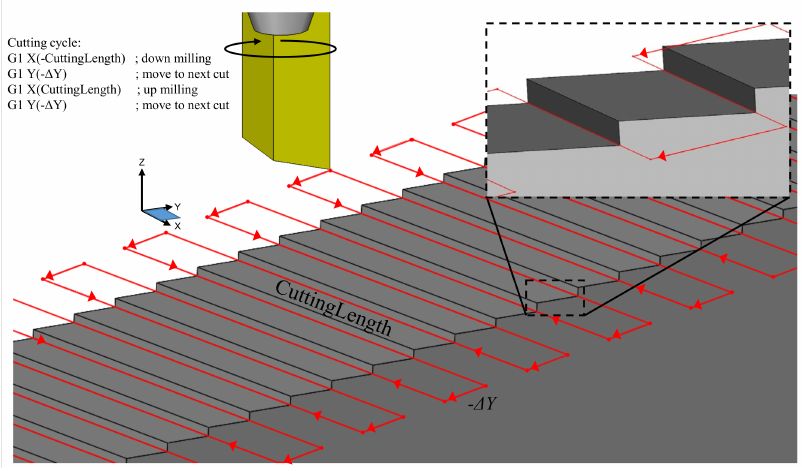
Figure 8. Tool path trajectory for four-axis micromilling involving RTCP.